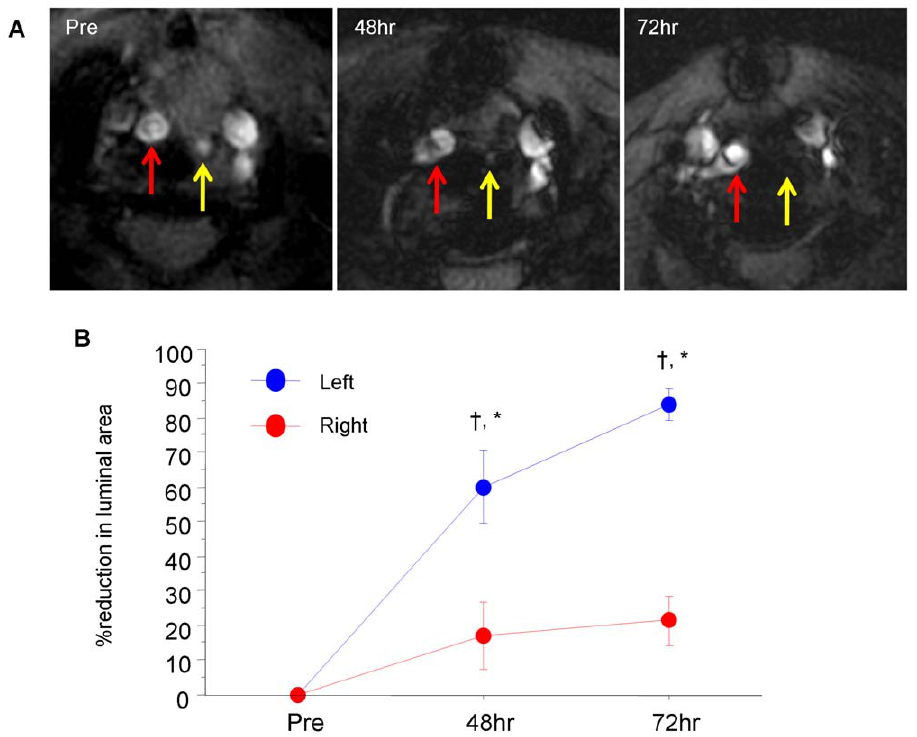
Figure 2. Serial invivo MRI of carotid arteries with FeCo/GC. ( A ) The ligated left carotid artery (yellow arrow), as expected, was smaller than the non-ligated right carotid artery (red arrow) prior to FeCo/GC injection (Pre). After FeCo/GC injection, T2* signal loss of the ligated left carotid artery was seen at 48 and 72 hours. Luminal area reduction was not seen in the control (non-ligated) right carotid artery. ( B ) Quantitative analysis showed significant % reduction in lumen area of ligated left vs. non-ligated right carotid arteries. { p=0.03 vs. Pre, *p=0.03 vs. right carotid.